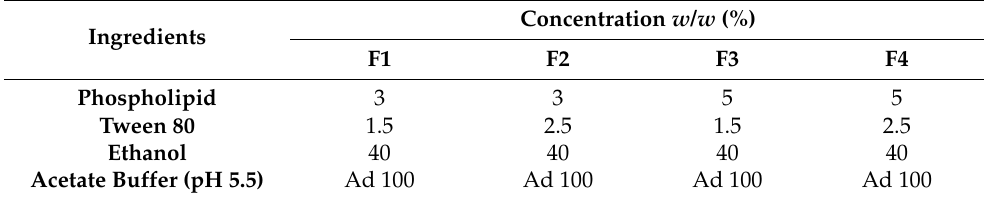
Table 8. Formulas for optimization transethosomal